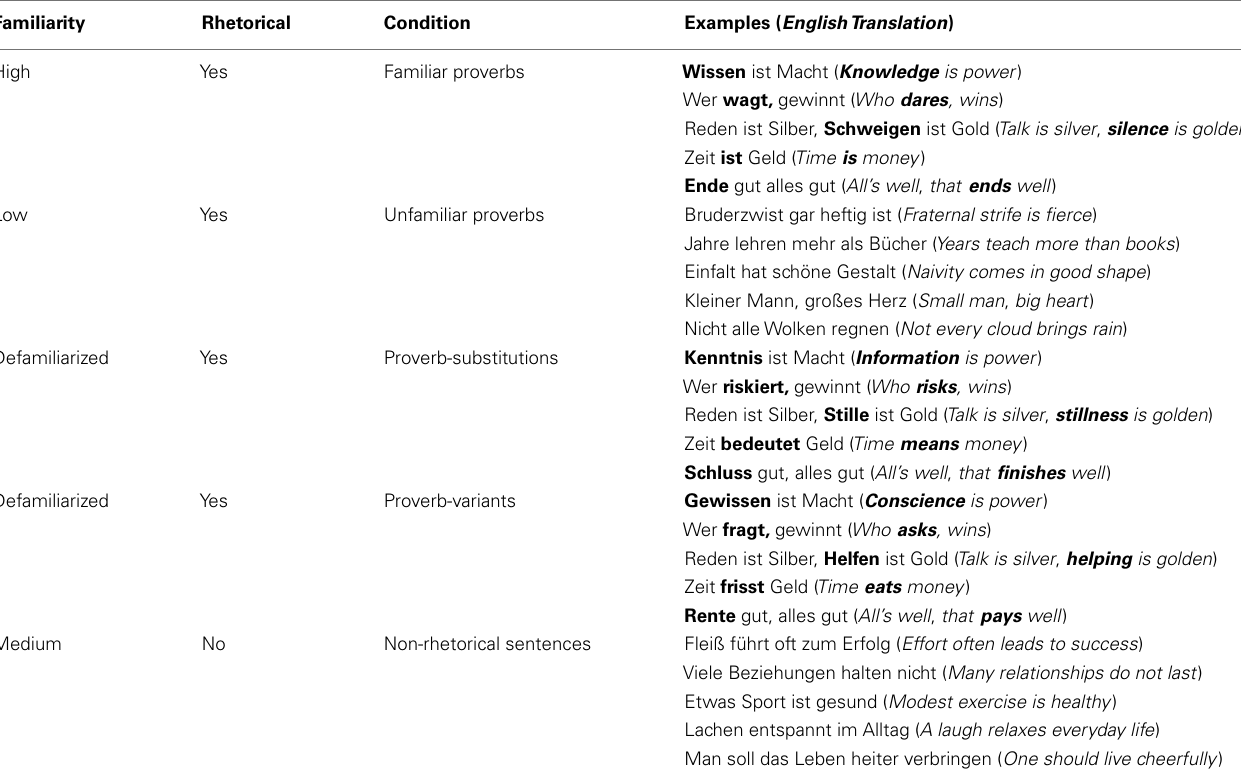
Table 1 | Condition